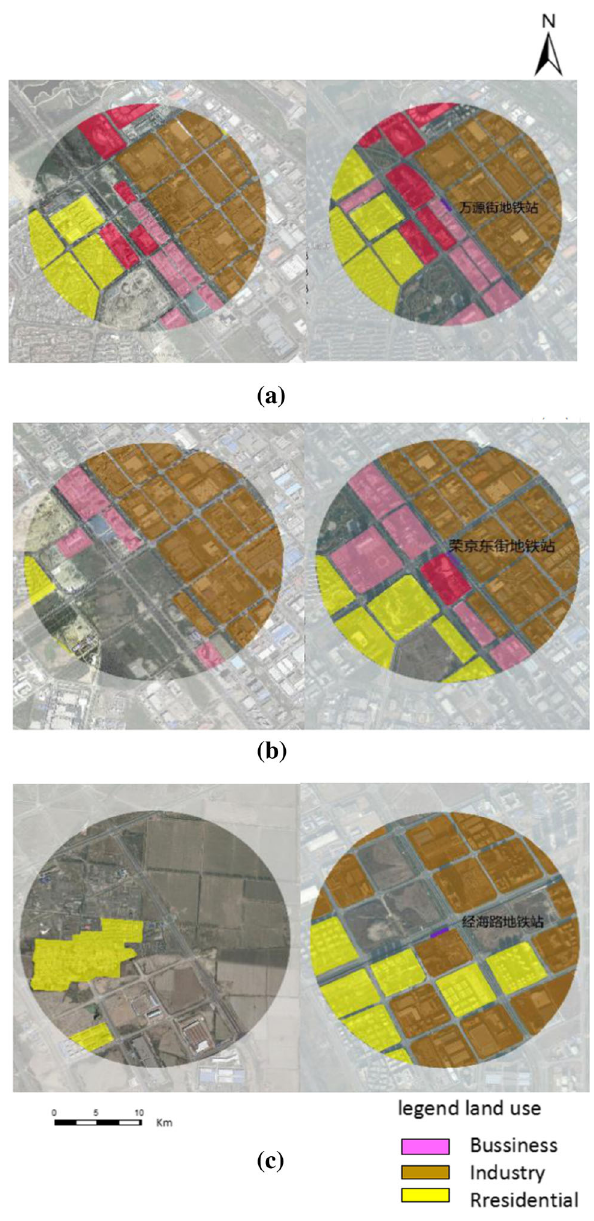
Fig. 5 Land use in 2008 ( left ) and 2015 ( right ) around three light rail